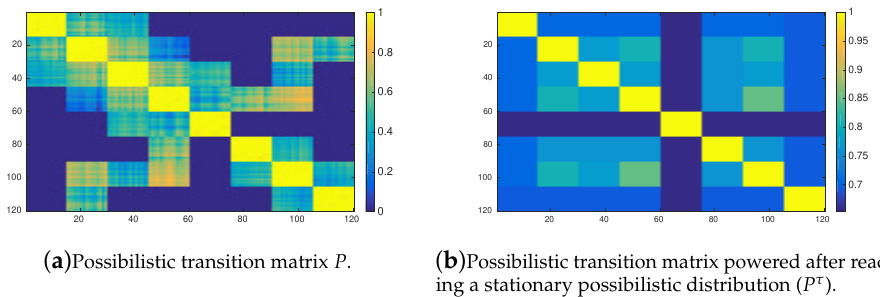
Figure 4. Possibilistic transition matrix induced by the YPRF with nTH = 2 for the 120 tasks arranged into 8